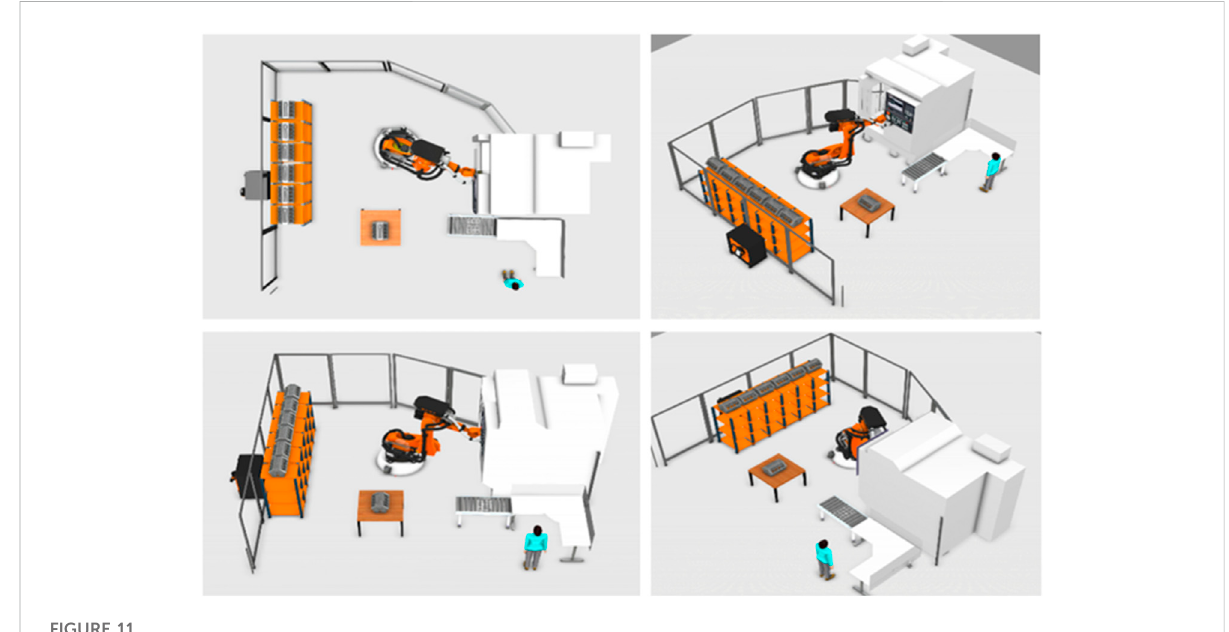
Fenceless manufacturing (Human, Machine and